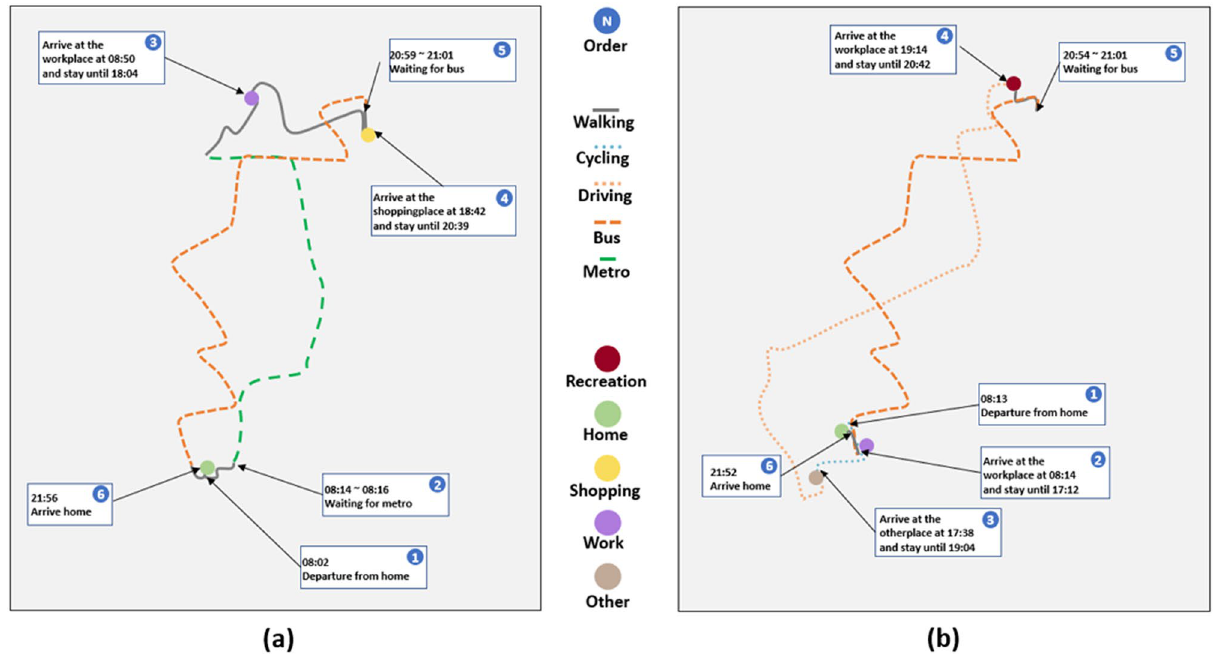
Figure 6. The trajectories of two agents ( a , b ) of ordinary worker group pattern on day1. ( a , b ) are the trajectories of two agents belonging to the ordinary worker we selected day1. The main reason for